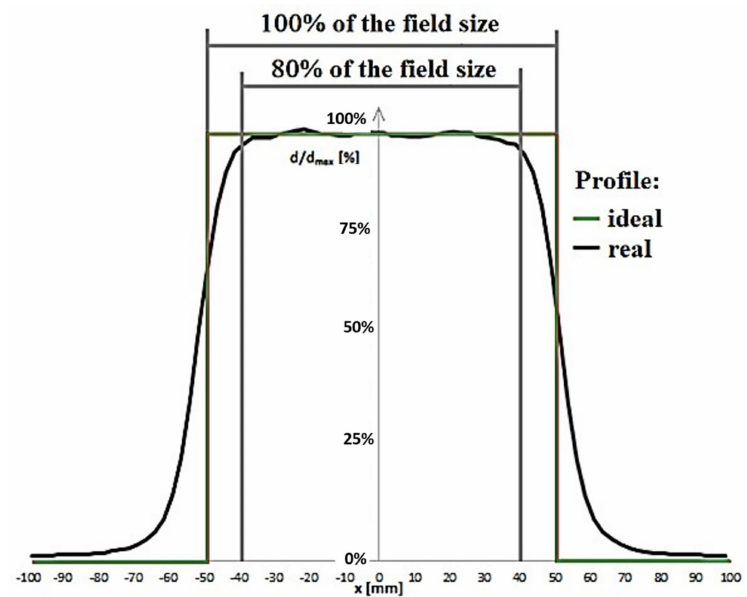
Figure 4. Typical beam profile for radiotherapeutic applications.